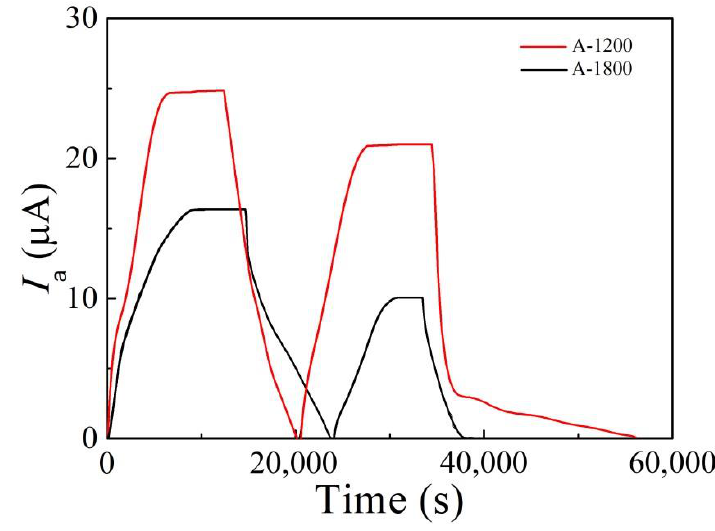
Figure 3. Hydrogen permeation curves of A-1200 and A-1800 steels. Table 2. Hydrogen permeation parameters of A-1200 and A-1800 steels.